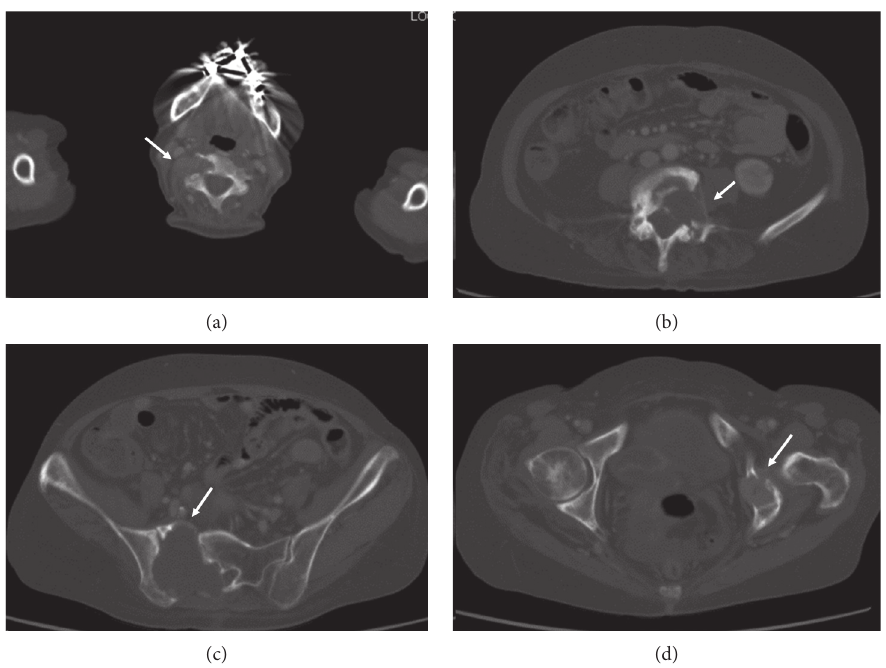
Figure 1: Computed tomography revealing bone metastasis (arrow). (a) C5, (b) L4, (c) S1, and (d) left acetabular cartilage.